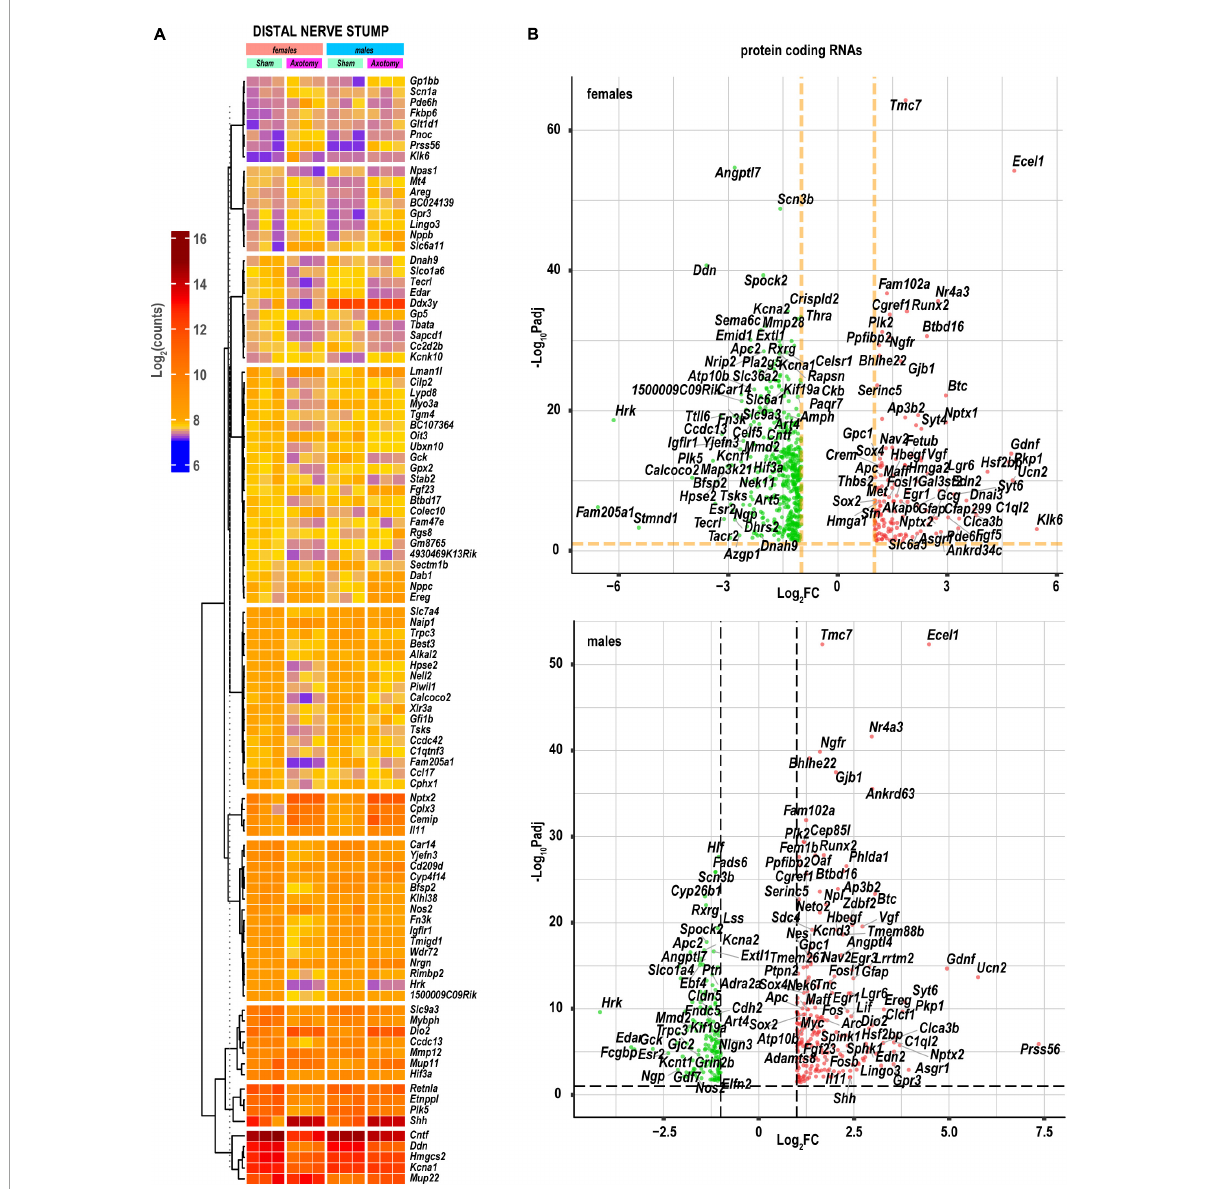
FIGURE2 Nerve axotomy induced distinct sexually dimorphic regulation of DEGs in female and male mice. (A) Hierarchical clustering plot of 100 most significant upregulated DEGs [log 2 FC > 1, P adj < 0.1, n = 6 mice/group, 2 mice/sample (pooled), 3 sample/group]. Heatmap colors correspond to log 2 (counts): blue, yellow, and red correspond to low, medium, and high gene expression, respectively. DEGs were clustered based on the Euclidean distance. (B) Significant DEGs in female (left panel) and male (right panel) mice. Volcano scatter plots show -log 10 P adj and log 2 FC. Red and green colors indicate up- and down-regulated DEGs, respectively. Thresholds (log 2 FC > 1 or log 2 FC < –1) and –log 10 P adj < 0.1 are indicated by yellow dashed lines. Selected DEG symbols are